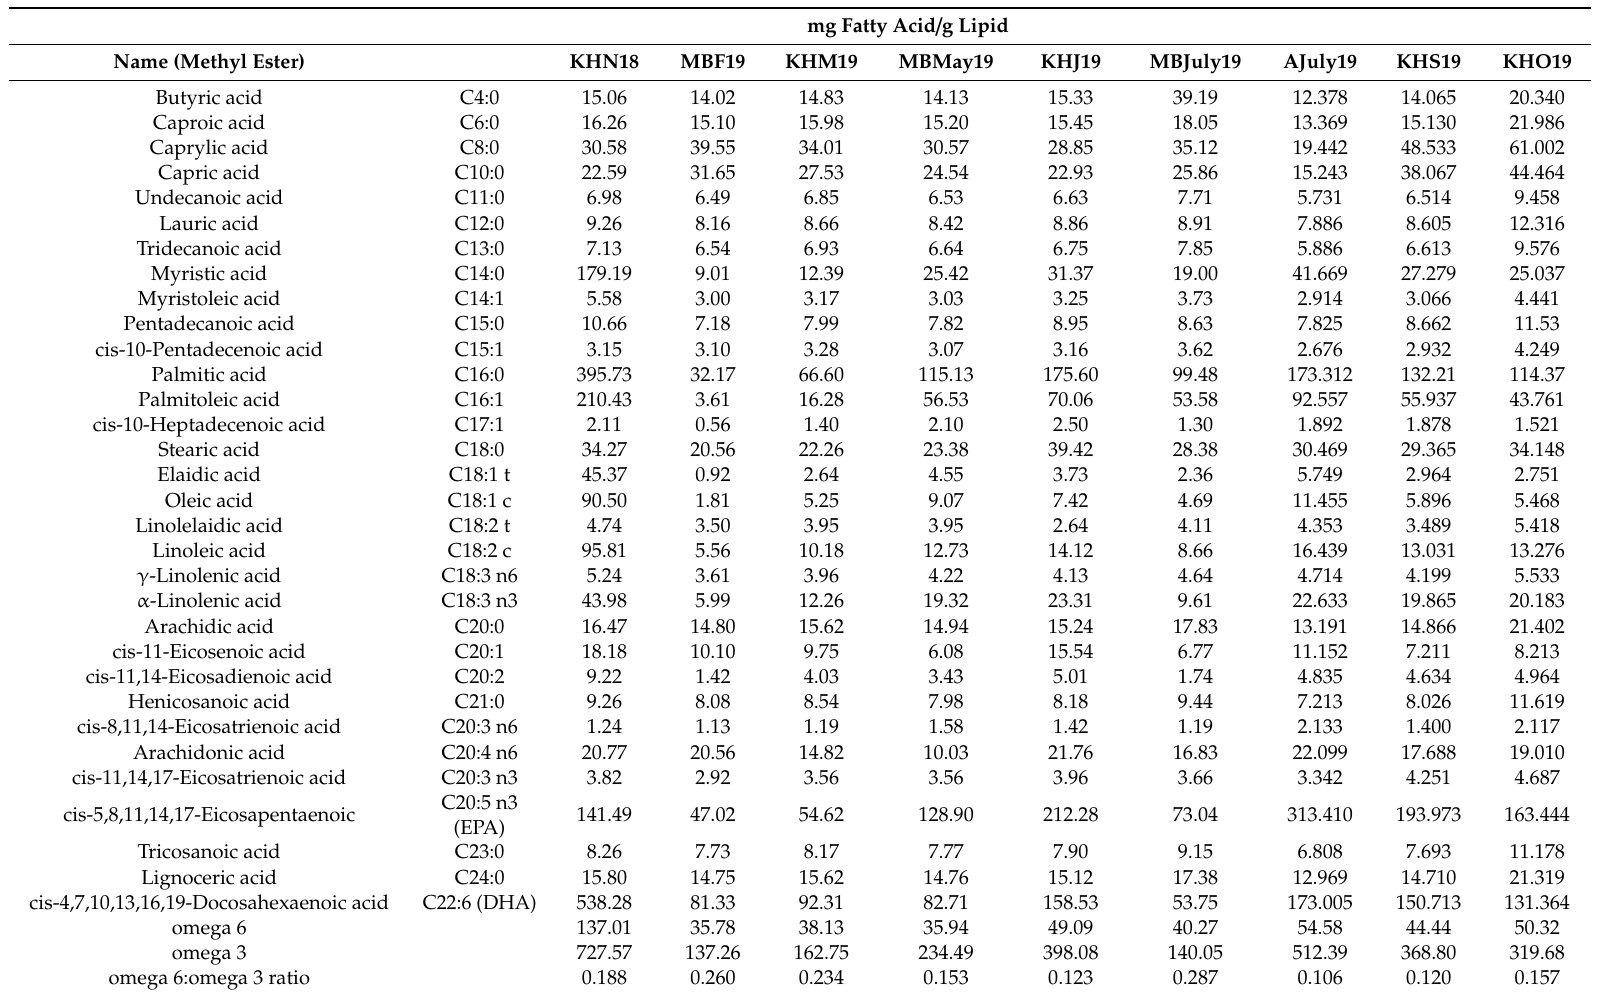
Table 3. Fatty acid composition (mg / g lipid) of mussel Protamex ® hydrolysates. All 9 samples from the three sampling sites, Mulroy bay, Killary harbour and Ardgroom, collected from November 2018 to October 2019, were used for gas chromatography mass spectrometry (GCMS)-based fatty acid analysis. mg Fatty Acid / g